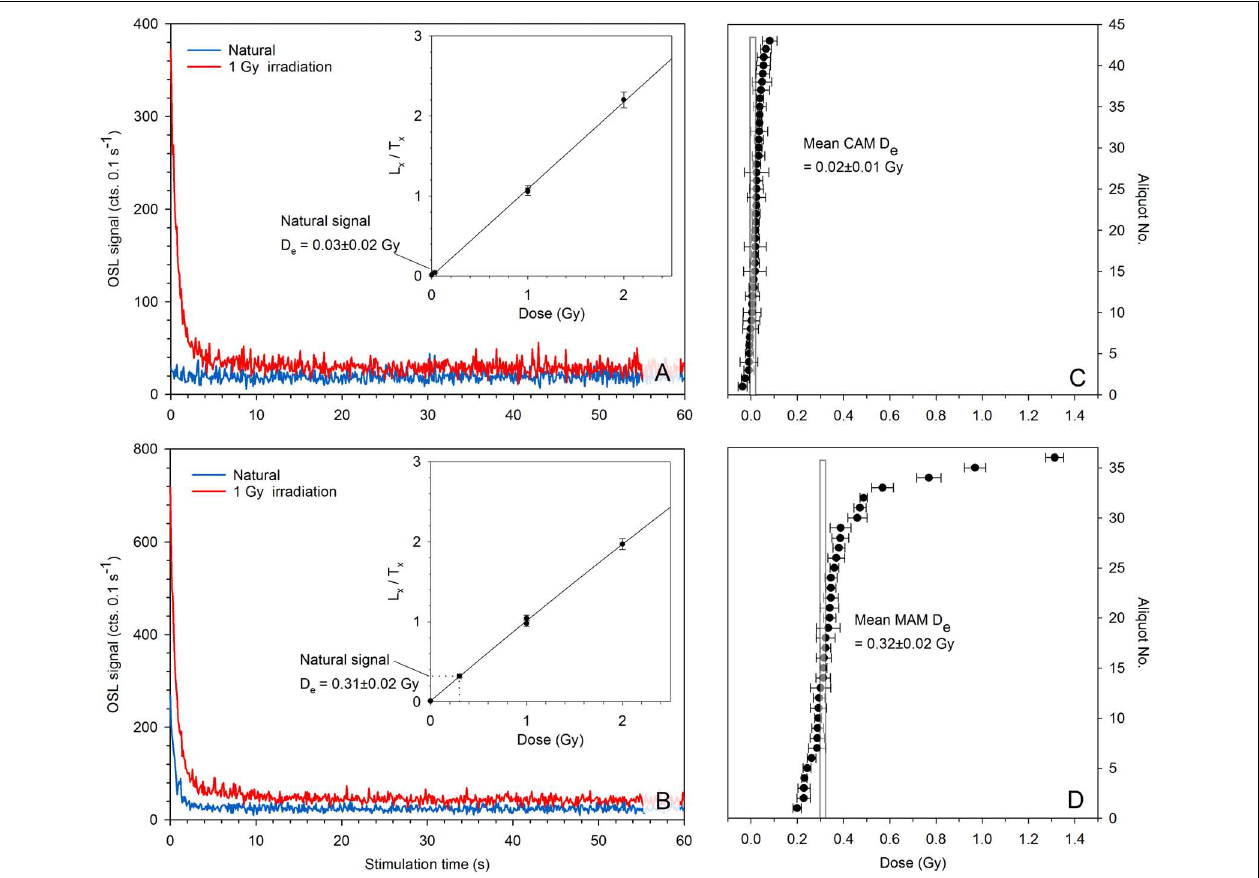
FIGURE 9 | Examples of OSL decay curves for representative aliquots of (A) a modern (ST1) and (B) an older (ST3) sample. This graph shows that the natural signal in the modern sample is too low for proper age determination. The inset displays the dose-response curve of the respective aliquot. Also shown are the dose distribution plots of (C) the modern and (D) the older example. For the latter, the positively skewed spread and high overdispersion of the D e values call for the application of the Minimum Age